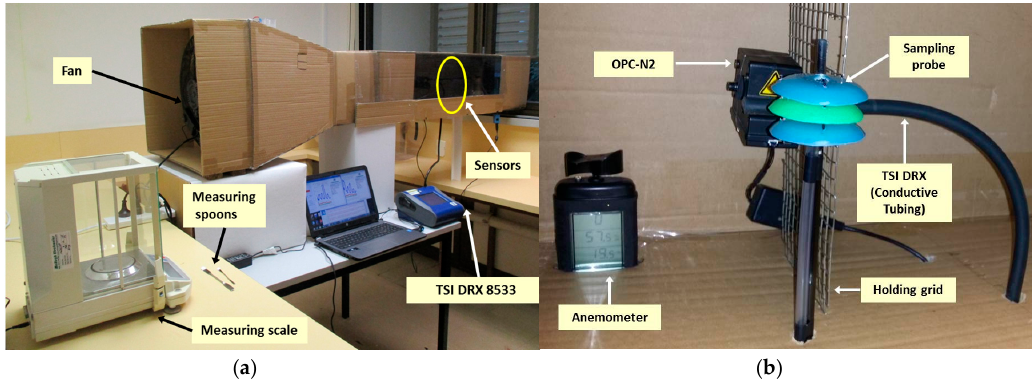
Figure 9. Wind tunnel and equipment used for the variable wind speed tests, ( a ) overall view of the wind tunnel and equipment used, and ( b ) test area set with the anemometer, probe, OPC-N2 and TSI DRX.